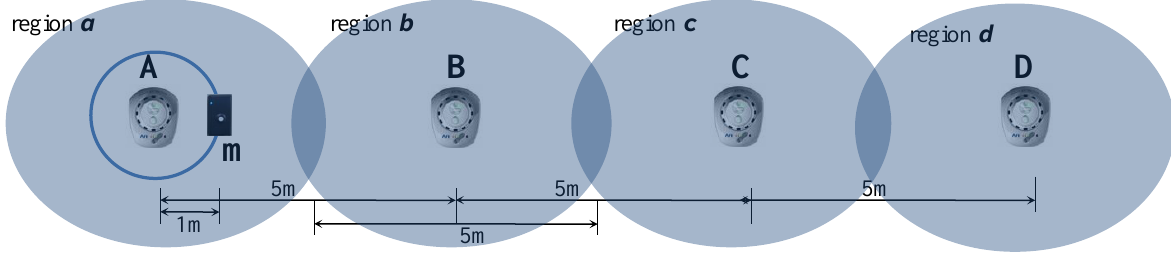
Figure 10. Setup used to measure location-awareness.